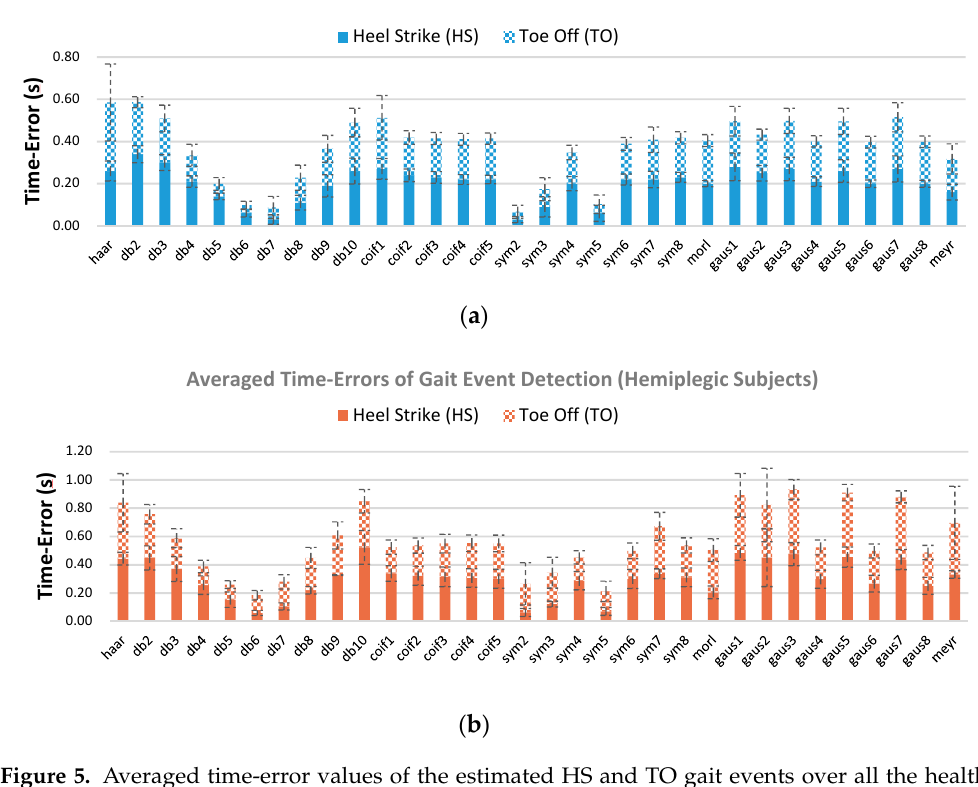
Figure 5. Averaged time-error values of the estimated HS and TO gait events over all the healthy subjects ( a ) and all the hemiplegic subjects ( b ) when using 32 commonly applied mother wavelets. The vertical dashed lines indicate the standard deviation.